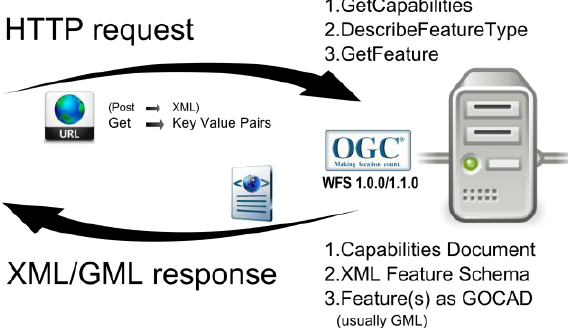
Figure 6: WFS communication